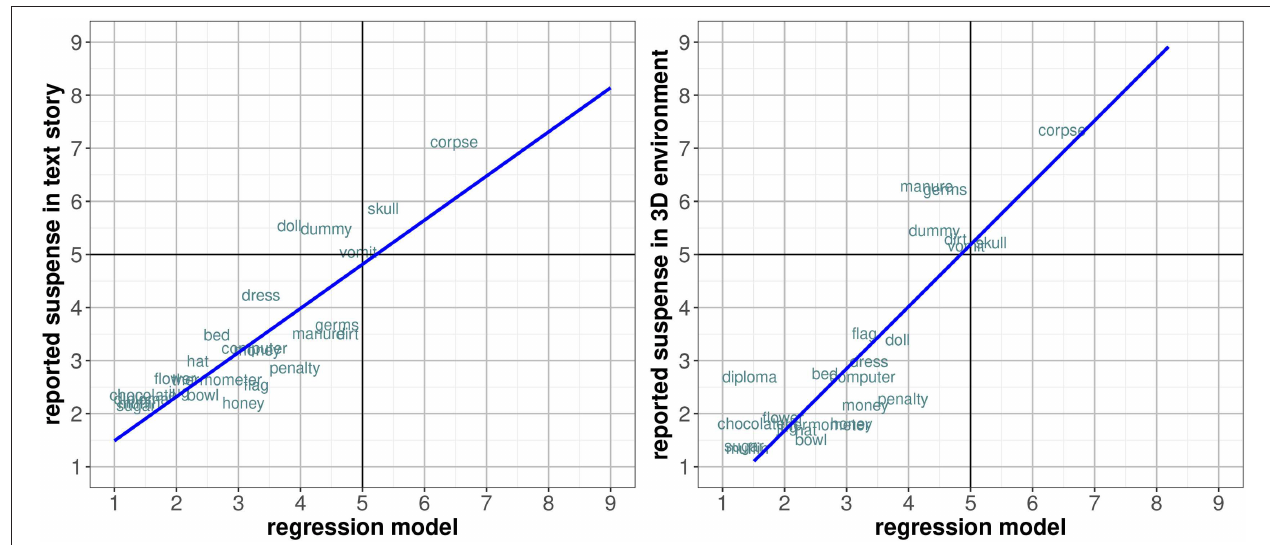
FIGURE 6 | Comparison of correlation between Spanish S-ANEW regression model and the reported suspense in the textual story (Left) and the interactive 3D environment (Right)